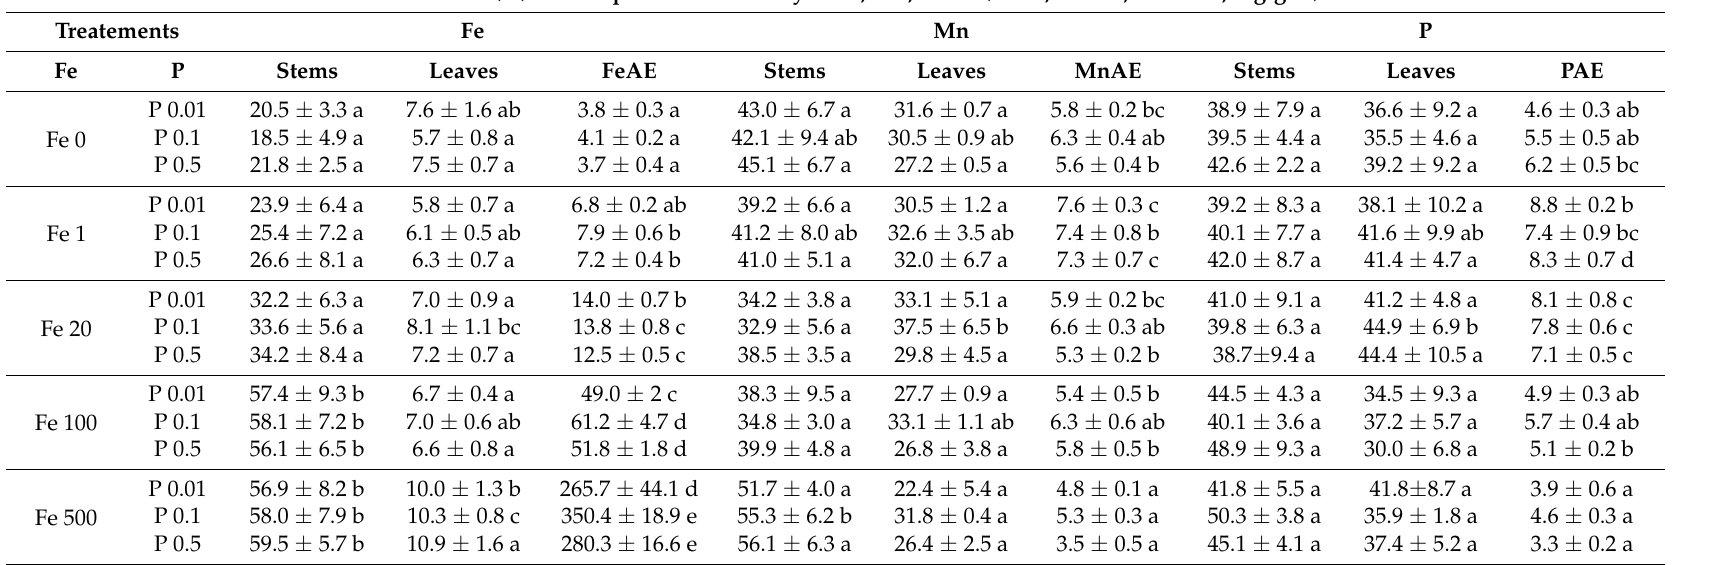
Table 3. Effect of Fe and P on the translocation of Fe, Mn, and P from roots to the stems and leaves, and acquisition efficiency of Fe, Mn, and P (FeAE, MnAE, and PAE). Translocation (%) and Acquisition Efficiency of Fe, Mn, and P (FeAE, MnAE, and PAE, mg · g − 1 ) Treatements Fe Mn P Fe P Stems Leaves FeAE Stems Leaves MnAE Stems Leaves